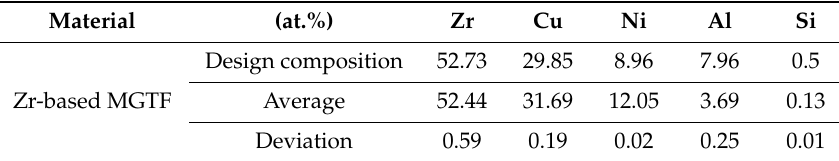
Table 2. Chemical composition of Zr-based MGTF coating analyzed by EDS.